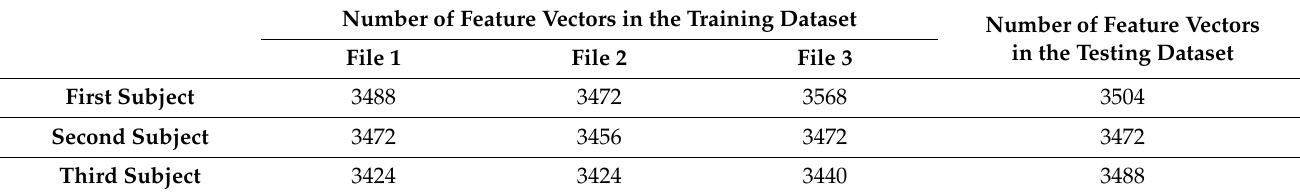
Table 1. Number of PSD samples for the three